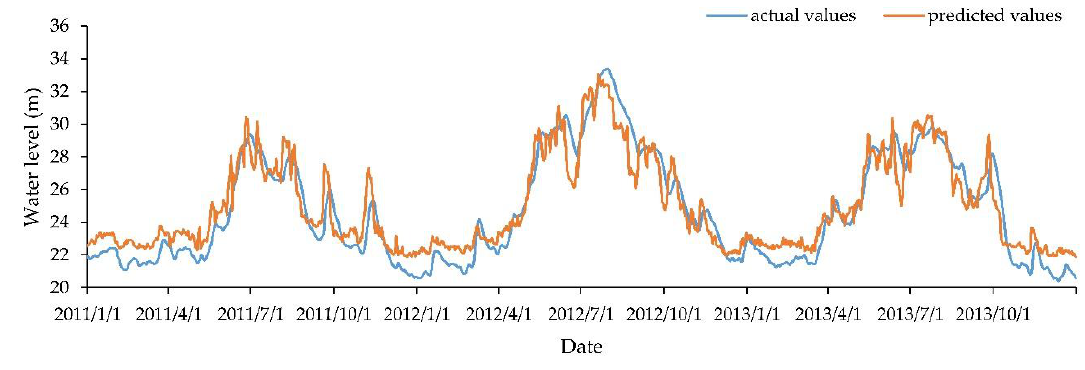
Figure 8. Forecasting results of Dongting Lake water levels using the SVM model.